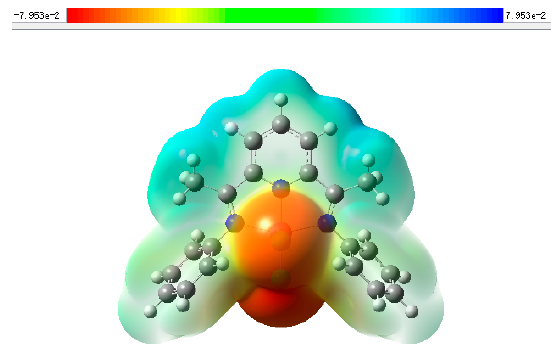
Figure 5. The electrostatic potential (ESP) of complex 2 .